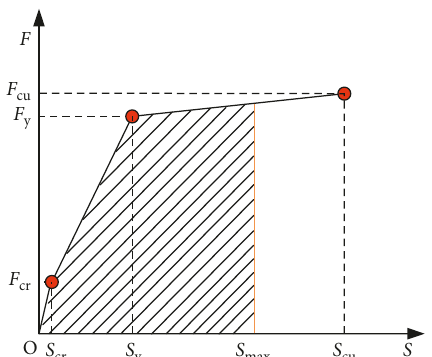
Figure 10: Force-deflection diagram of RC beams under impact